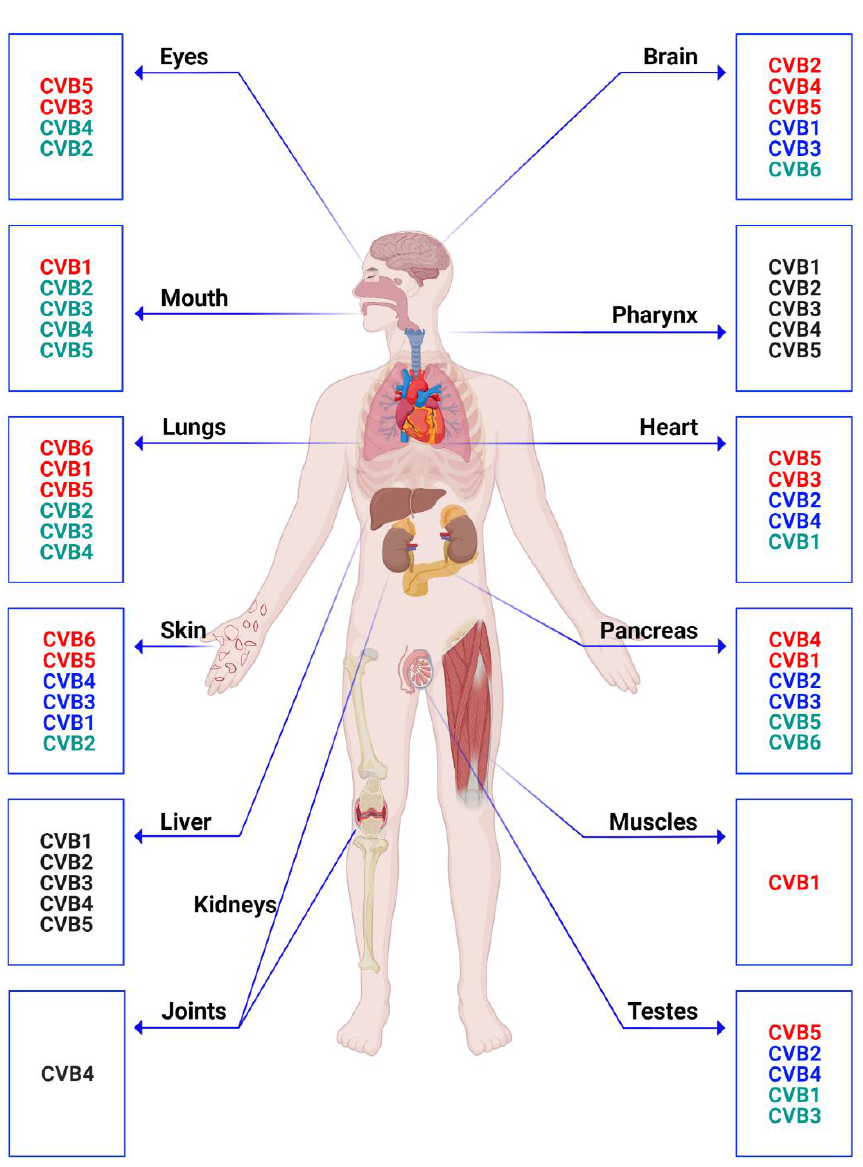
Figure 1. Organs affected by various serotypes of CVBs in humans. The serotypes affecting various organs are color-coded in each box. The red text indicates more commonly detected serotypes than others (blue and green) in that order, and the black text indicates no such differences. The information indicated in the figure was synthesized from Feigin and Cherry ’ s Textbook of Pediatric Infectious Diseases, 8th Edition 2019, and the figure was created using biorender.com.